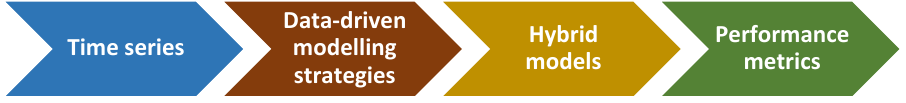
Figure 2. The general framework of drought prediction and evaluation.